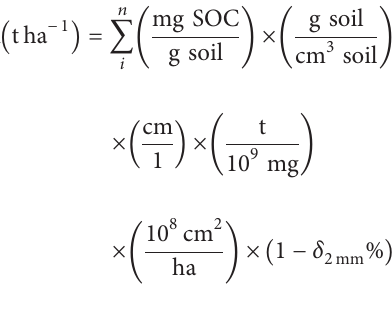
Figure 1: Location of the Mbo plain in Cameroon. (a) DEM (b) and topographic (c) maps of the Mbo plain showing location of the study